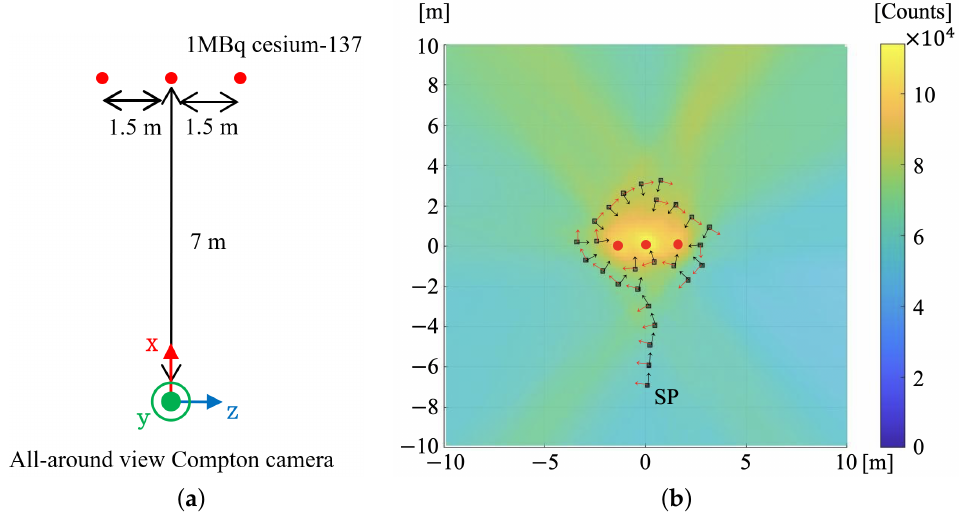
Figure 12. Simulation condition and result of multiple radiation sources concentrated in a specific area: ( a ) Three 1 MBq cesium-137 were positioned on a straight line, and the distance between the radiation sources was set to 1.5 m. ( b ) The blue and red arrows represent the directions of the first and second principal components, respectively. The ground truth of the position of the radiation source is represented by a red dot. The path approaching the radiation source was generated along the direction of the first principal component. Subsequently, a path was generated, which moved toward the second principal component and surrounded the radiation